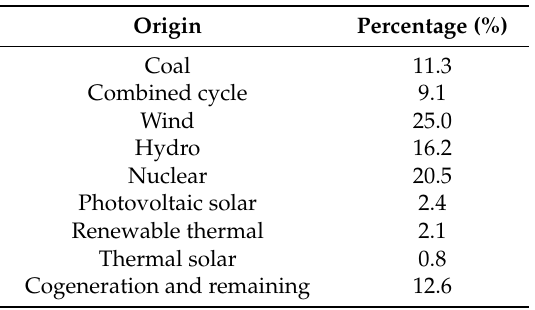
Table 3. Origin of electrical